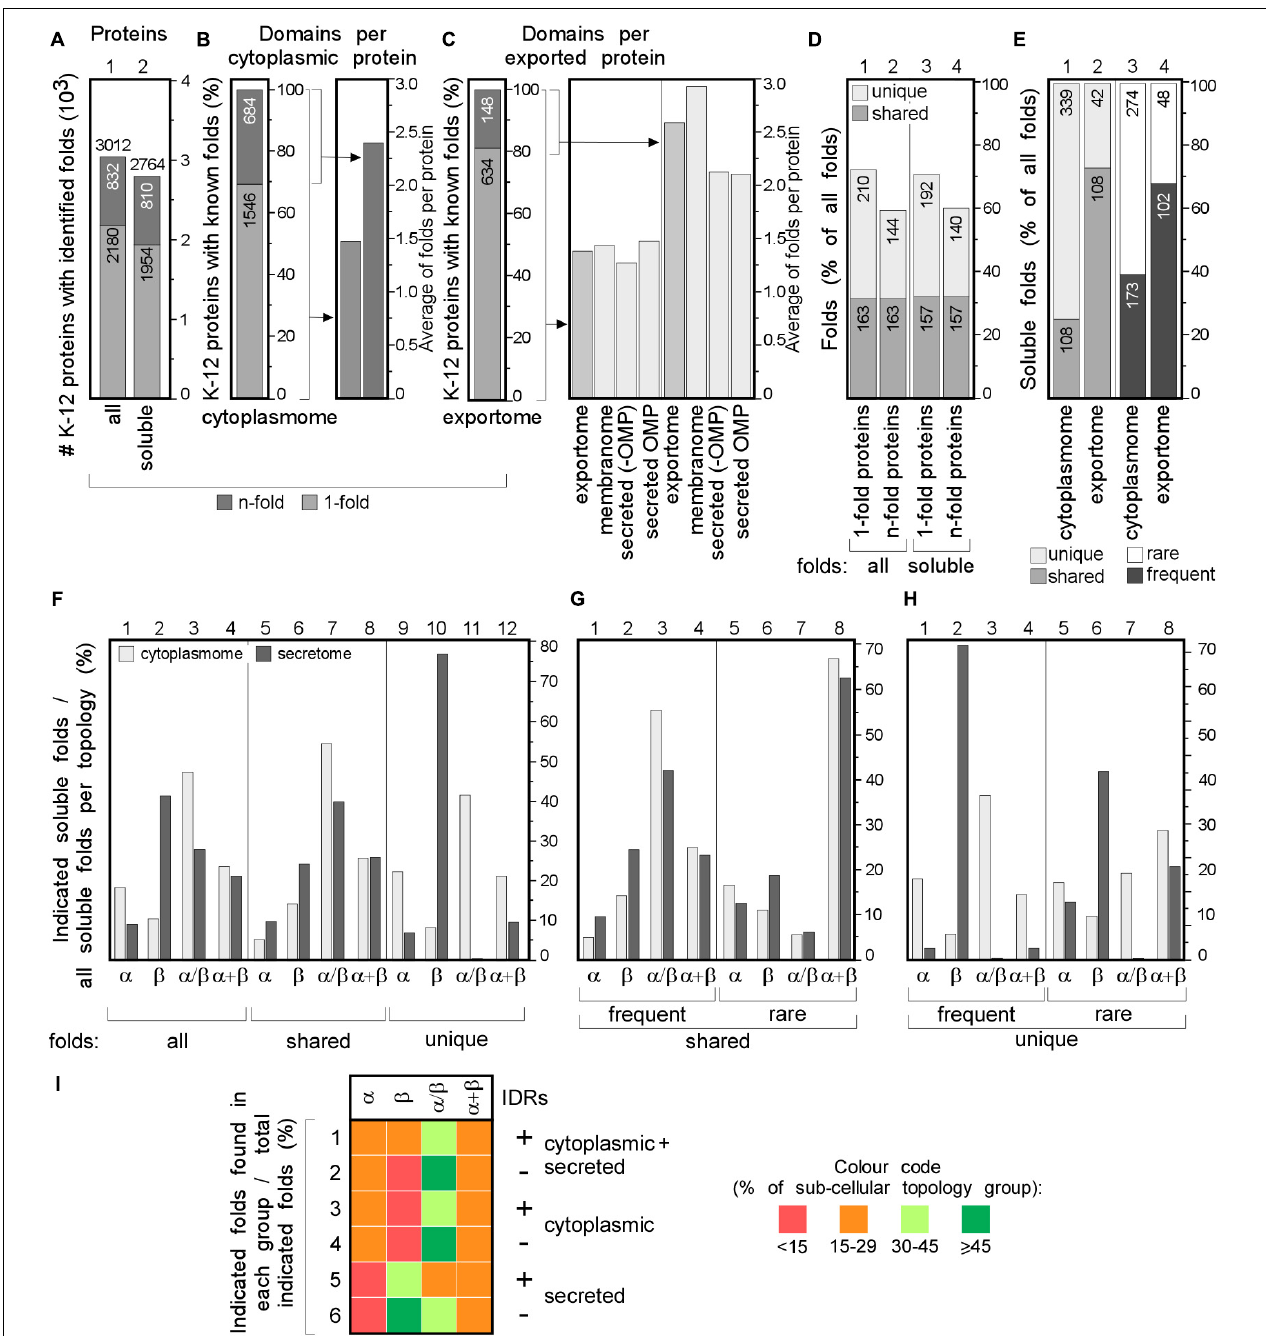
FIGURE 4 | Structural differences in cytoplasmic-secreted proteomes. (A–C) Structural fold analysis (numbers of proteins are indicated in the bars). (A) K-12 proteome with al identified folds or only soluble folds for one (onefold) or multiple (n-fold) proteins. (B) Domains per cytoplasmic protein. Left: percentage of proteins that carries only one or more folds. Right: average folds per protein for all cytoplasmic proteins or n-fold proteins. (C) Domains per exported protein. Left: percentage of proteins that carries only one or more folds. Right: average folds per protein for exported proteins. (D) Percentage of folds unique to either cytoplasmic or exported proteins or shared among the two groups. (E) Soluble folds in cytoplasmic or exported proteins based on carrying one or more folds (left) and carrying rare ( ≤ 3 times in the proteome) or frequent ( ≥ 4 times in the whole proteome) folds (right). (F) Indicated soluble fold classes in cytoplasmic and secreted proteins. On the Left: all soluble folds in each topology group; middle: unique and right: shared folds between the two topology groups. Unique (G) and shared folds (H) are divided in rare and frequent folds and plotted for cytoplasmome and secretome in α , β , α / β and α + β classes. (I) Heat-map of fold class occurrence in the proteins with (+) and without (–) IDRs for different topology classes. OMP, outer membrane proteins; IDR, intrinsically disordered region; N/A, none found.